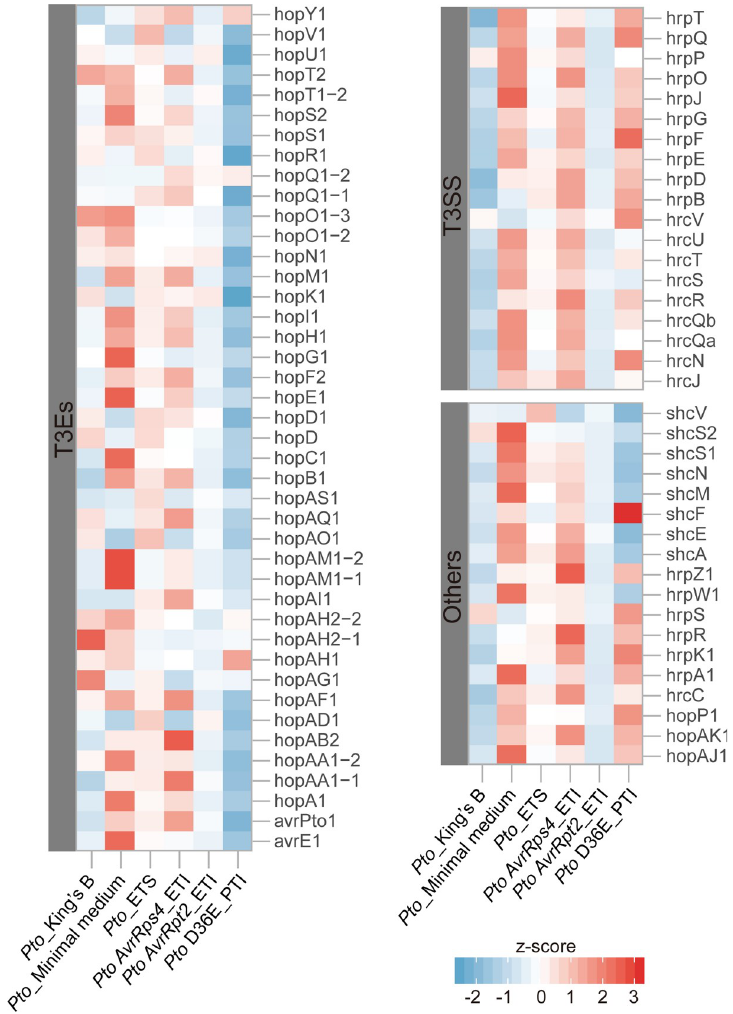
Fig 11. Expression profile of the T3SS and T3E genes of Pseudomonas syringae pv. tomato DC3000 ( Pto ) in T3SS/ T3E-inducible minimal medium versus nutrient-rich King’s B and across a range of Arabidopsis thaliana lines with different ETS, ETI and PTI phenotypes. Pto , Pto AvrRps4 ( Pto strain ectopically expressing T3E AvrRps4), Pto AvrRpt2 ( Pto strain ectopically expressing T3E AvrRpt2), and Pto D36E ( Pto mutant strain lacking all 36 known Pto T3Es) infection in Arabidopsis thaliana Col-0 with ETS, ETI, ETI, and PTI phenotypes, respectively. T3SS, type III secretion system. T3E, type III effectors. Others, T3SS helper and chaperone. The transformed Z-score value was generated from FPKM (fragments per kilobase per million mapped sequence reads) values for each condition. The raw sequencing data was generated by Nobori et al. 2018 [25]. nutrients are able to impact the virulence response of Xvh , we measured the activity of hrpF in Xvh ( hrpF _promoter_ Luc ) growing in minimal media containing peptone (carbon and nitro- gen source) and pyruvate (carbon source), individually. Peptone and to a lesser degree, pyru- vate, were able to repress the induction of hrpF (Fig 12). Further, when either peptone or pyruvate was co-infiltrated into NTJ2 sorghum leaves with Xvh , the induction of hrpF was sig- nificantly reduced (Fig 12). These data are consistent with previous studies in Pseudomonas syringae and Xanthomonas campestris pv vesicatoria [26,28]. These data support the conclu- sion that the differential expression of T3SS genes is the result of differences in the nutrients/ metabolites that accumulate in planta after inoculation with the pathogen. Peptone is a